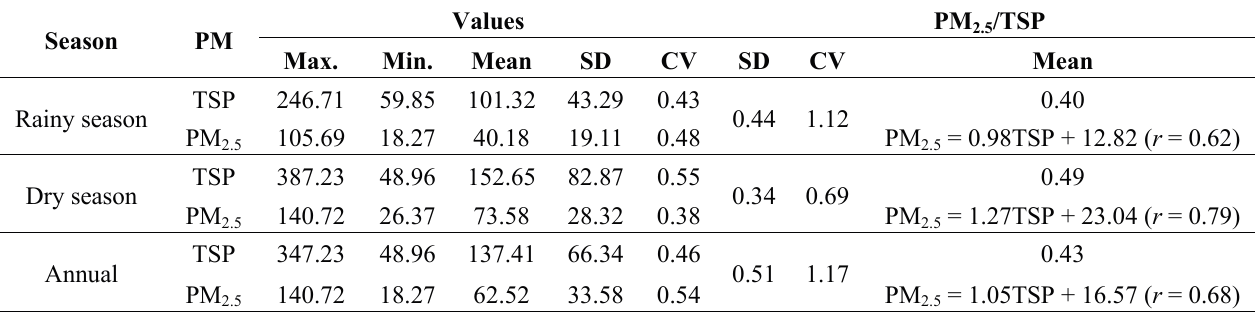
)) ( μ g·m − 3 ), the PM /TSP ratios, 2.5 2.5 in Dafushan forest 2.5